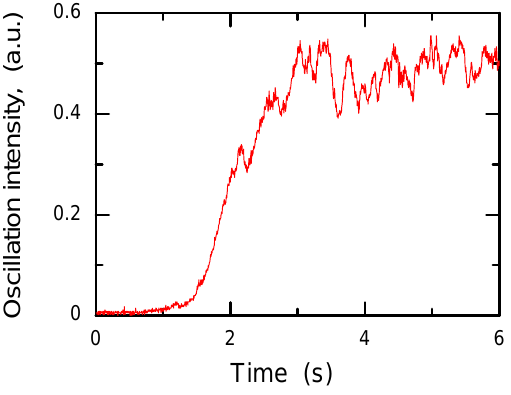
Figure 21. Temporal dynamics of coherent oscillation intensity in CdF = 5.7 × 10 17 cm − 3 ) crystal. Total intensity of counter-propagate pump beams ( N Ga ~ 200 mW/cm 2 at equal intensities of these beams. Intensity fluctuations in the saturation area are due to poor mechanical stability of the optical